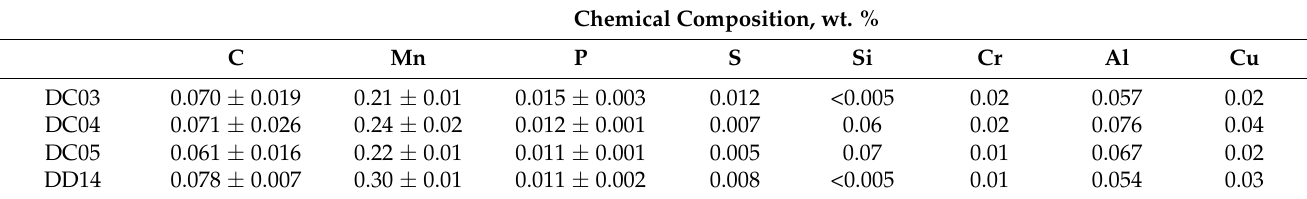
Table 2. The chemical composition of the investigated steels (optical emission spectroscopy). Chemical Composition, wt. %